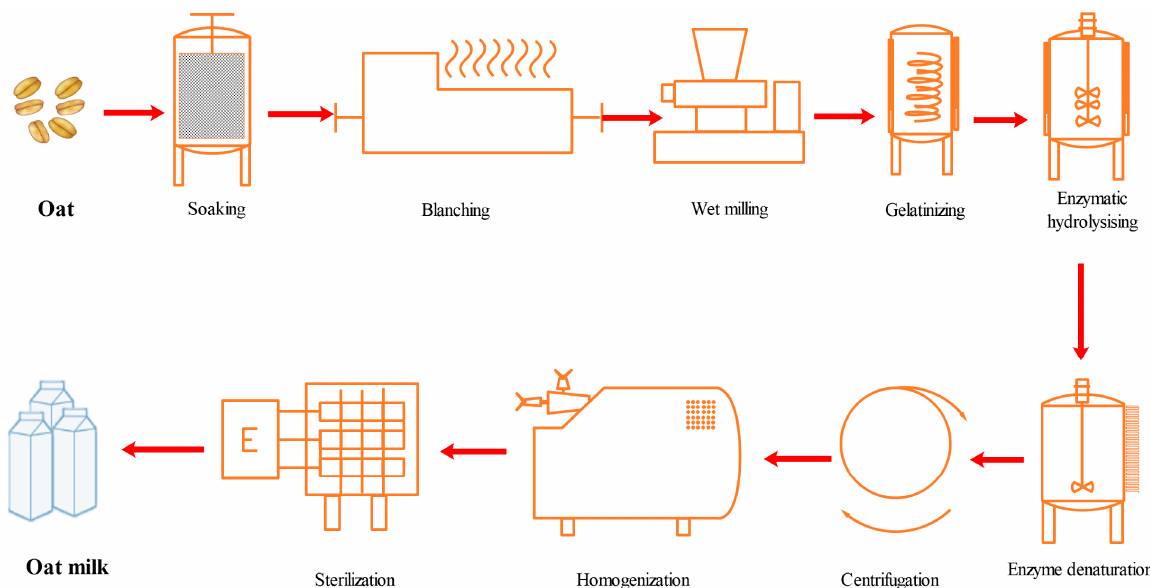
Figure 1. The manufacturing process of oat milk.